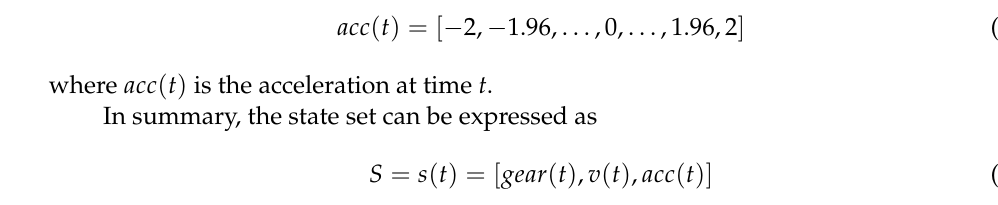
Figure 5. EC shift schedule curve.